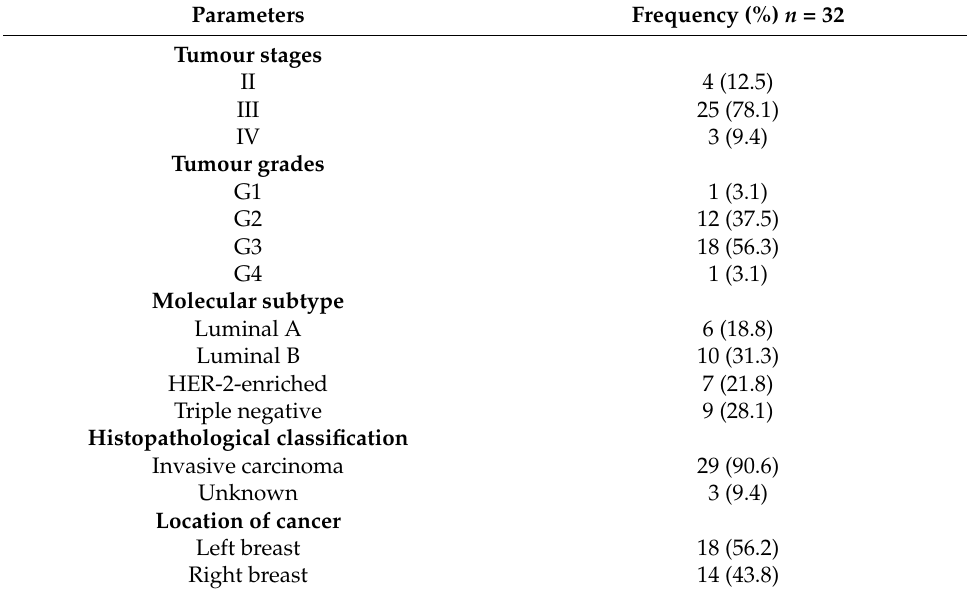
Table 3. Clinicopathological characteristics of breast cancer cases.